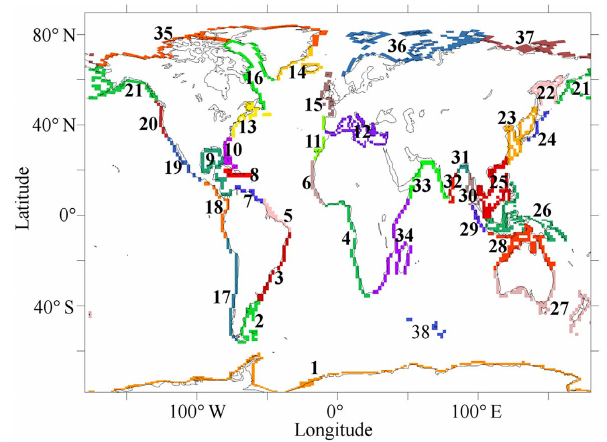
Figure 2. Model 228 Ra source